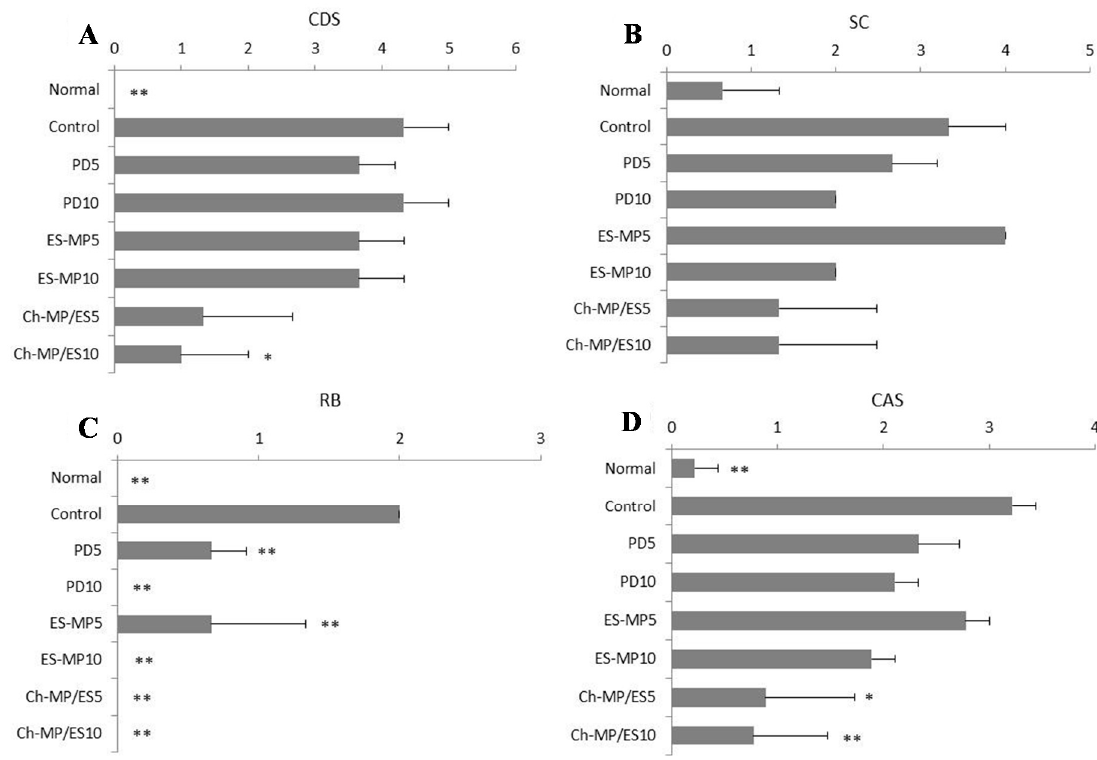
Figure 2. CDS, SC, RB and CAS after oral administration of each formulation in rats with TNBS-induced colitis. Efficay was evaluated from ( A ) CDS; ( B ) SC; ( C ) RB and ( D ) CAS. Normal (healthy), Control (non-treated), PD5 (5 mg PD/kg × 3 times (every 24 h)), PD10 (5 mg PD/kg × 6 times (every 12 h)), ES-MP5 (5 mg PD eq/kg × 3 times (every 24 h)), ES-MP10 (5 mg PD eq/kg × 6 times (every 12 h)), Ch-MP/ES5 (5 mg PD eq/kg × 3 times (every 24 h)), and Ch-MP/ES10 (5 mg PD eq/kg × 6 times (every 12 h)) were examined. The results are described as the mean ± S.E. ( n = 3). * p < 0.05, ** p < 0.01 vs. Control. CAS = (CDS + SC + RB)/3.